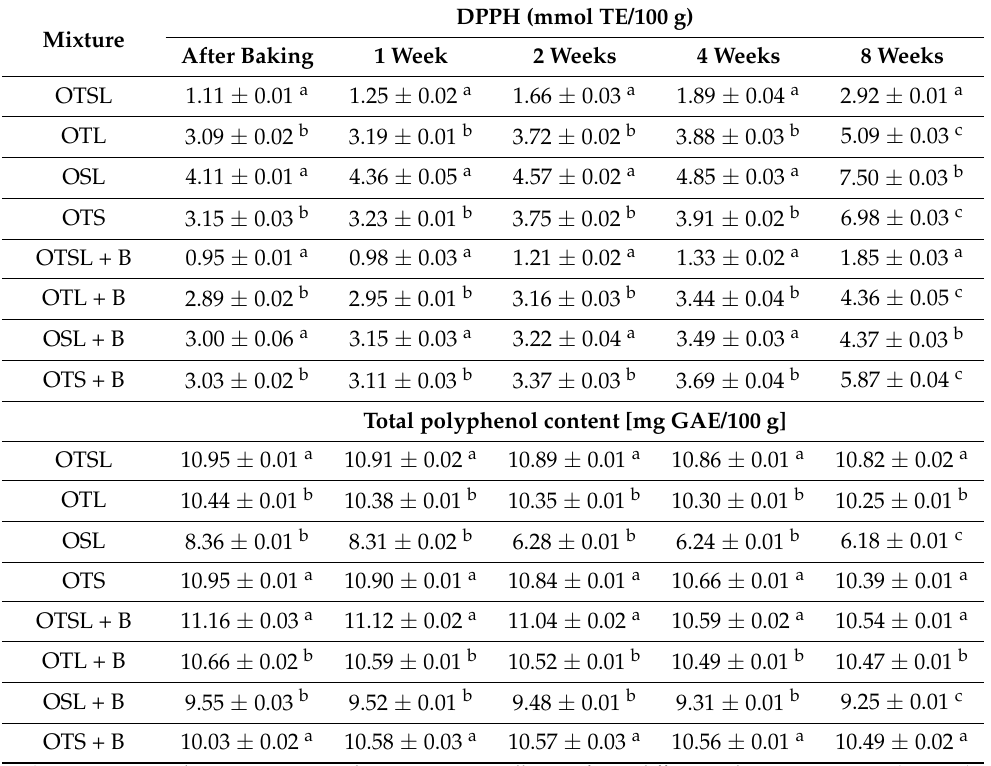
Table 6. Total polyphenol content and antioxidant activity.